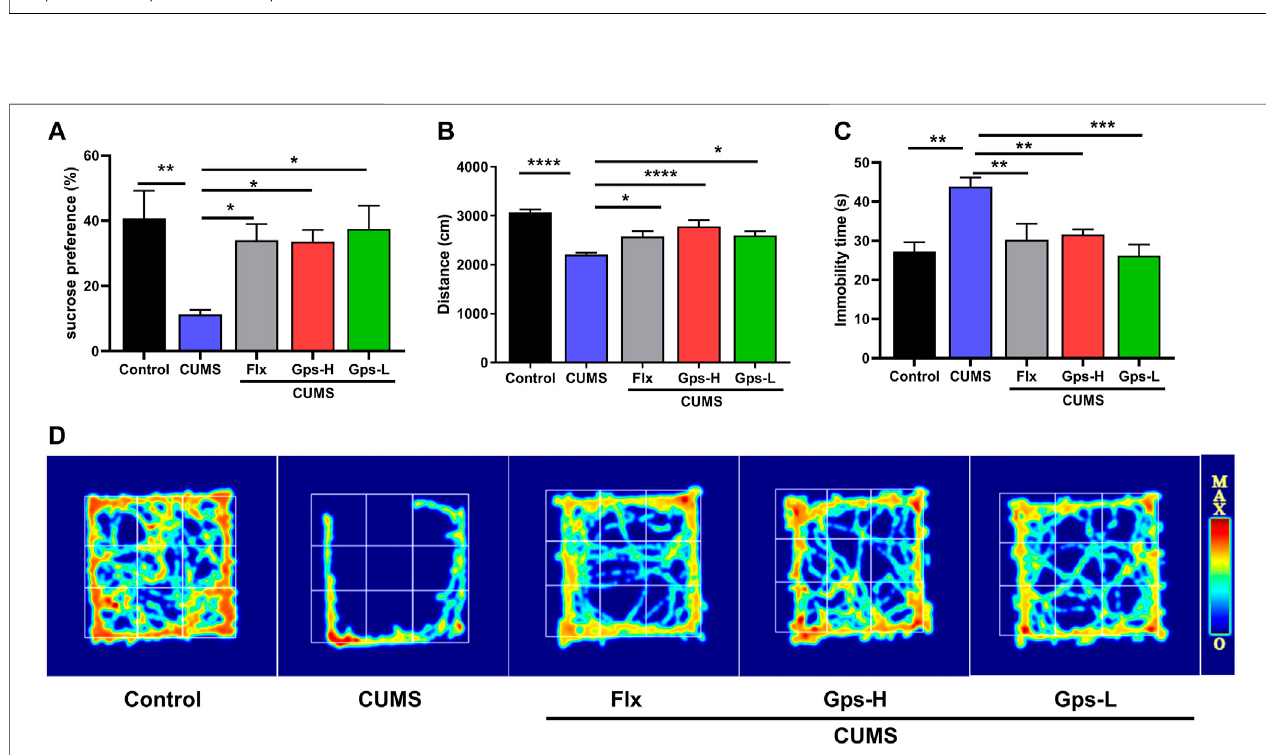
FIGURE 4 | Gps blocks CUMS-induced depression-like behaviors. (A) . Mean sucrose preference (%), (B) . Movement distance in the OFT, (C) . Immobility time in FST, and (D) . The activity thermograms of mice of vehicle-administered control mice and CUMS-subjected mice administered vehicle, Flx, and high and low doses of Gps, respectively. The results were expressed as mean ± SEM. n = 5 for each group. *, p < 0.05; **, p < 0.01; ***, p < 0.001; ****, p < 0.0001 vs. CUMS.